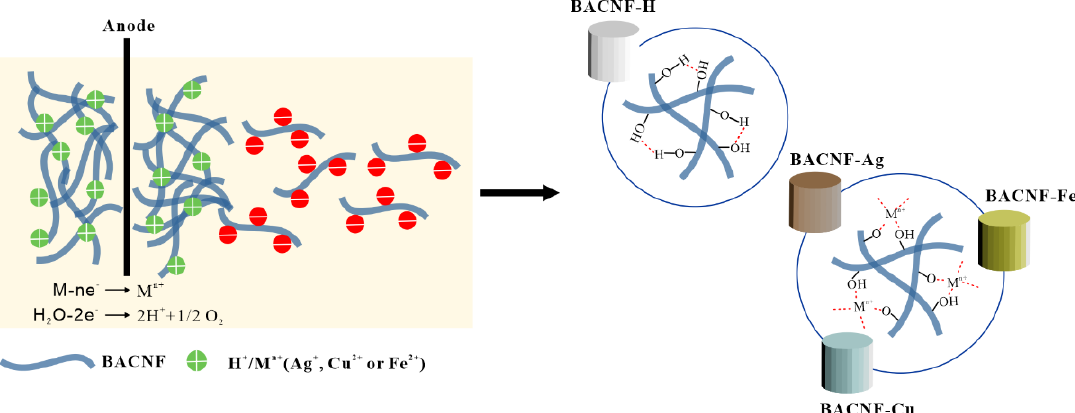
Figure 5. The scheme for synthesis carboxyl cellulose composite hydrogels containing silver, copper and iron ions was prepared by electrochemical method (reprinted from reference [176] with permission from Elsevier).